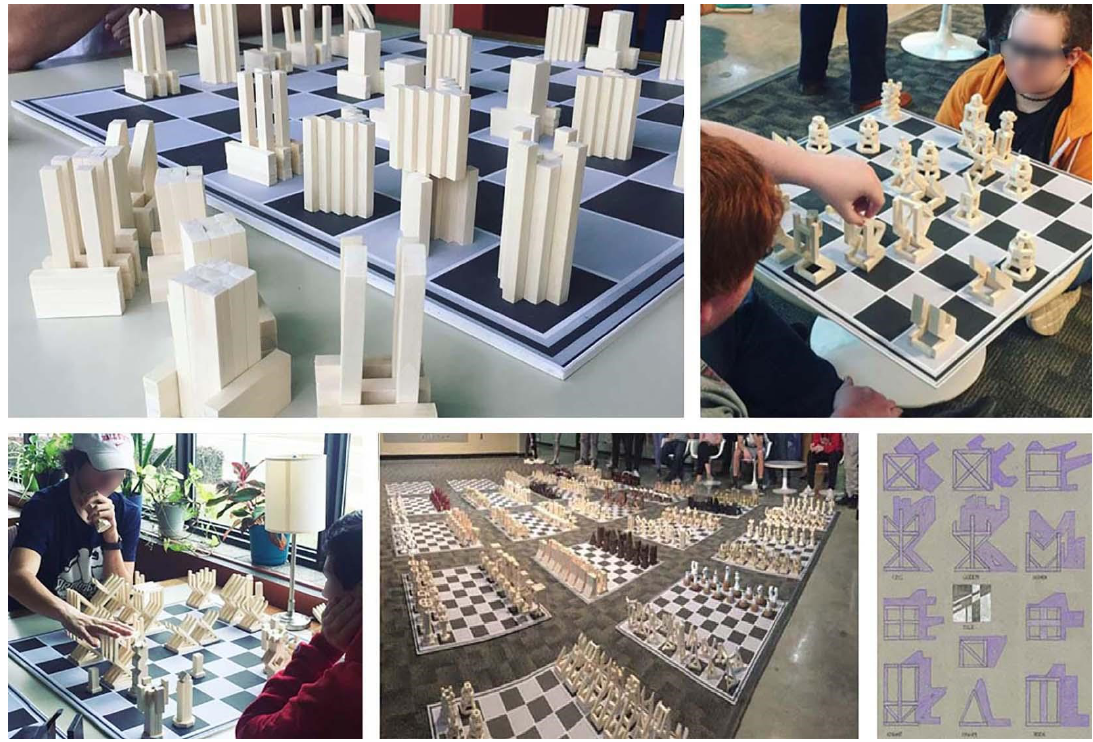
A studio-wide chess event tested the effectiveness of designs and invited college-wide